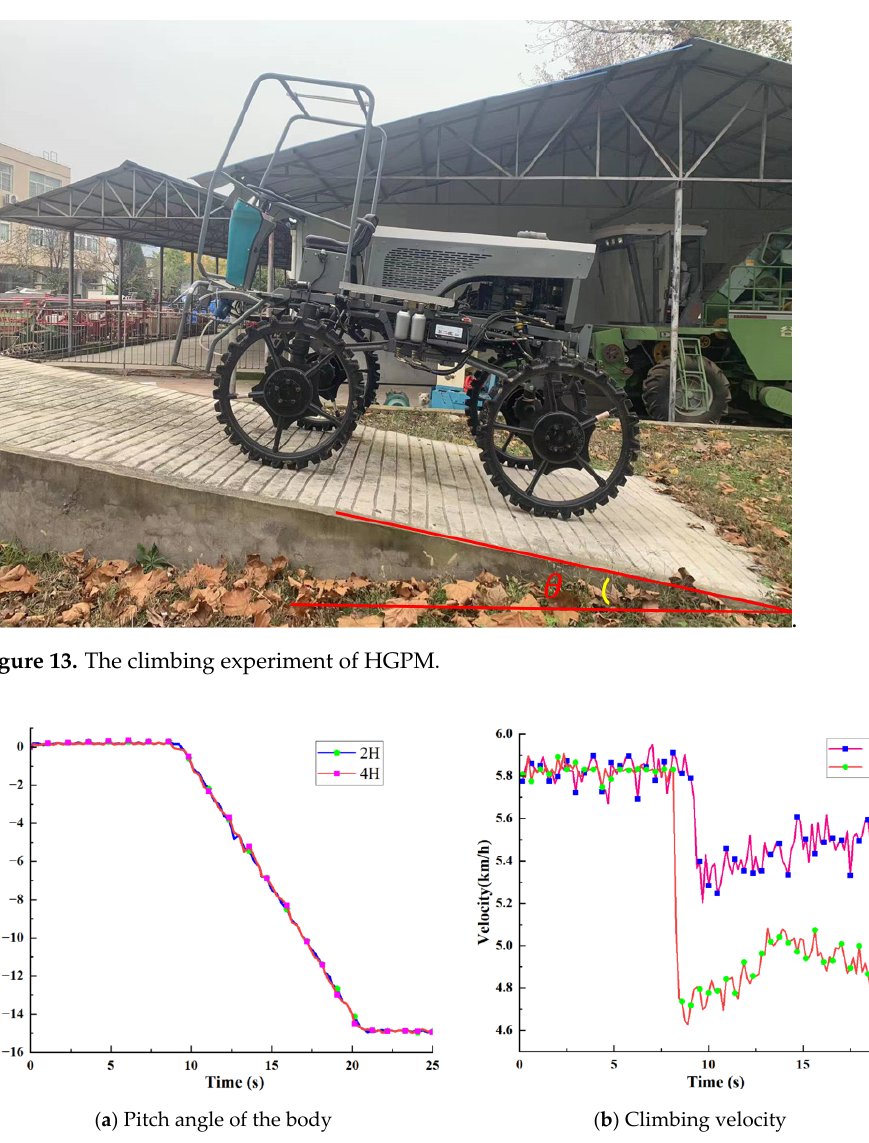
Figure 14. Climbing experiment results.